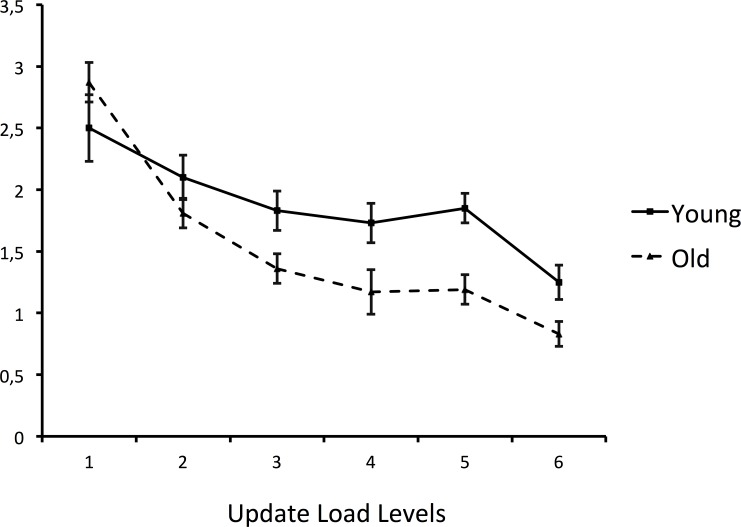
Updating Working Memory task (UWMT) performance (means and standard errors) as a function of updating load level and age group.Performance data on the Updating Working Memory Task (UWMT) were collected at each updating load level.